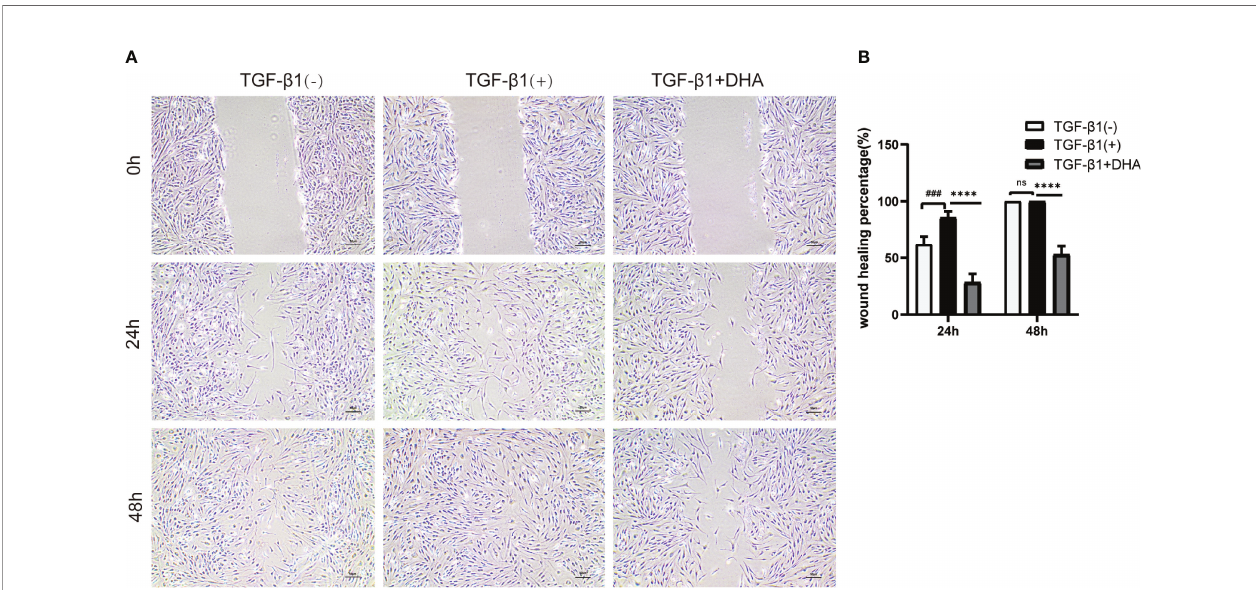
FIGURE 3 | DHA suppresses the migration capacity of GO-derived OFs. (A) Representative images of wound repair ability of GO OFs (n = 3). Scale bar = 50 m m. (B) Statistical analysis of the rate of wound closure. ### P < 0.001 compared with the control; *P < 0.05, ****P < 0.0001 compared with TGF- b 1 alone. ns denotes no statistical signi fi cance versus the TGF- b